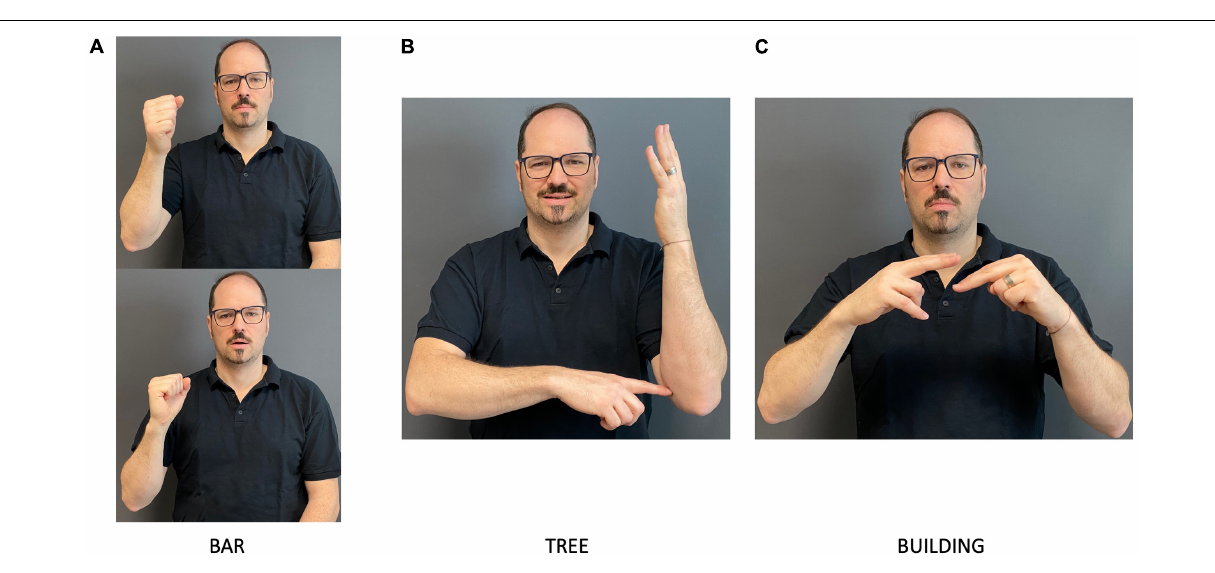
FIGURE 3 | Examples of lexical transfers. The signs are (A) BAR, (B) TREE and (C)